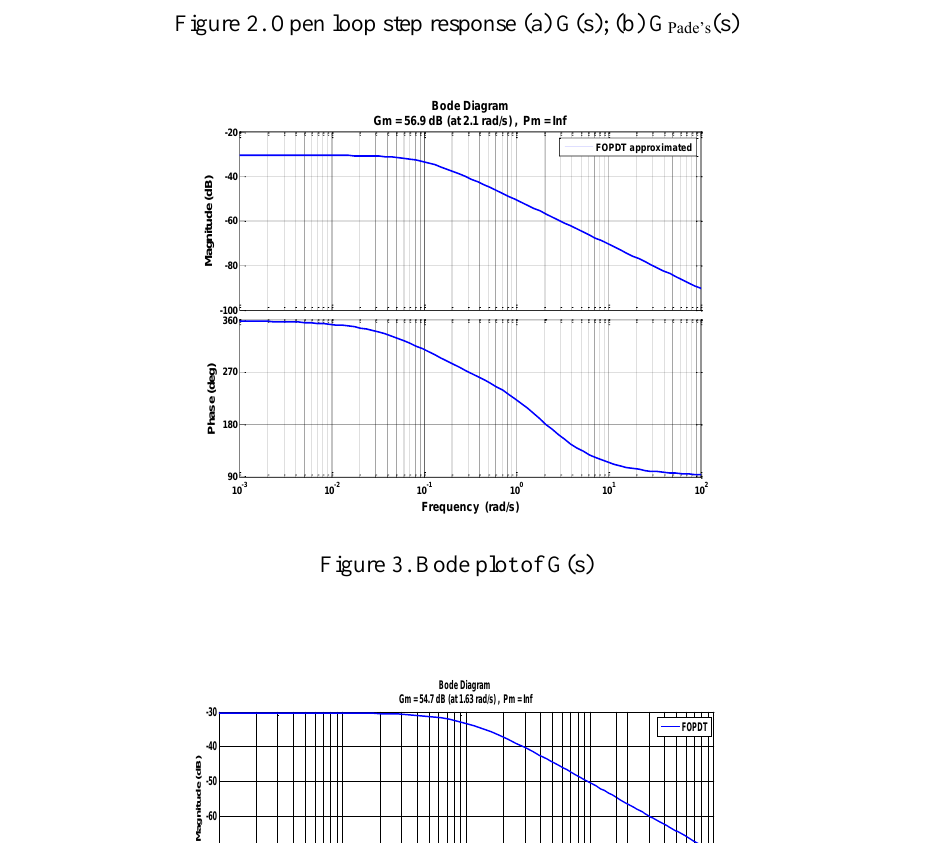
Figure 2. Open loop step response (a) G(s); (b) G Pade’s (s)